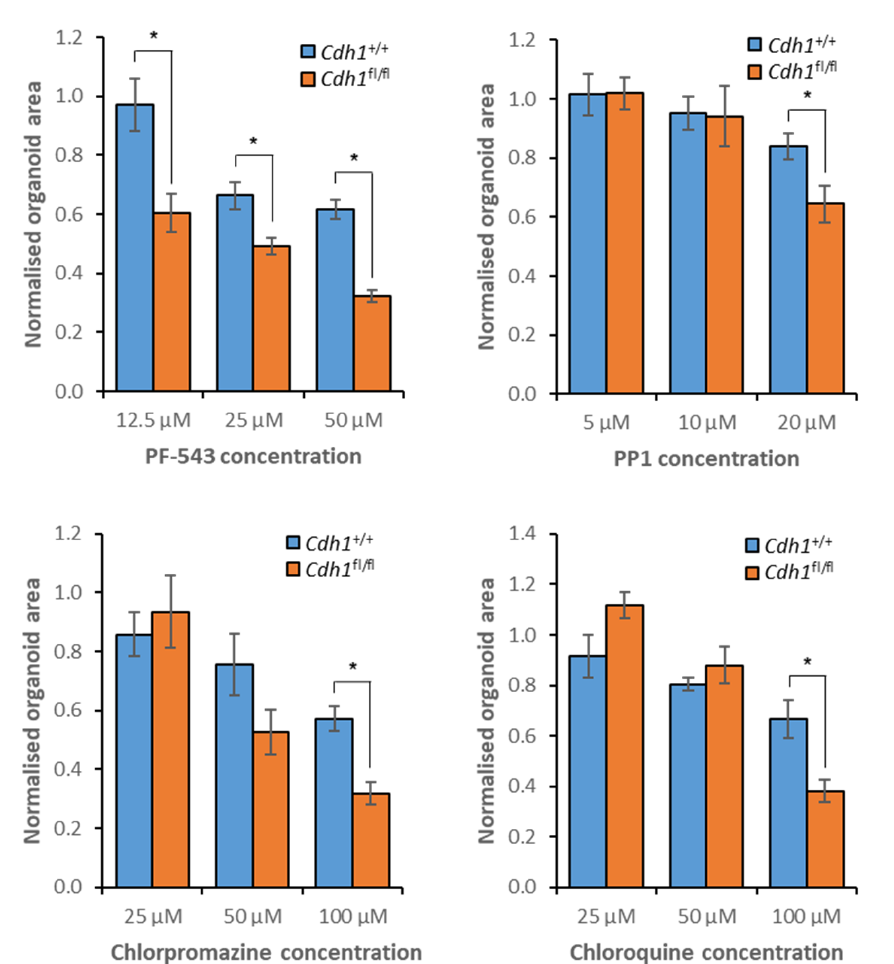
Figure 10. Sensitivity of mammary organoids to treatment with candidate synthetic lethal com- pounds. Both Cdh1 +/+ and Cdh1 fl/fl organoids were drugged, then viability was quantified through measurement of organoid area, normalized to vehicle controls. Average values were calculated from three biological replicates, with +/ − 1 standard error of the mean depicted by error bars. P -values were calculated using Student’s t -test; * p ≤ 0.05.